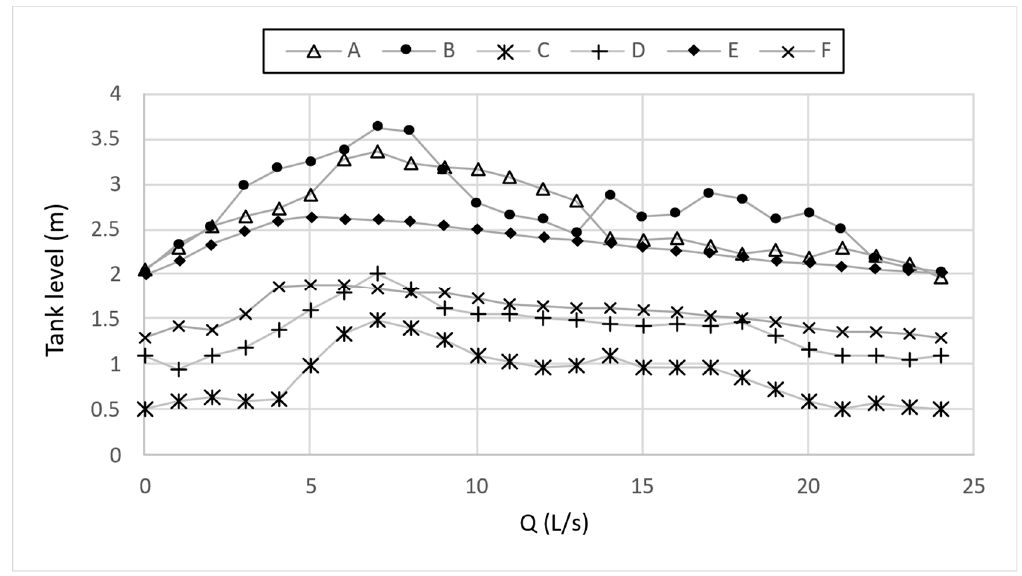
Figure 12. Evolution of tank levels in the Richmond network.